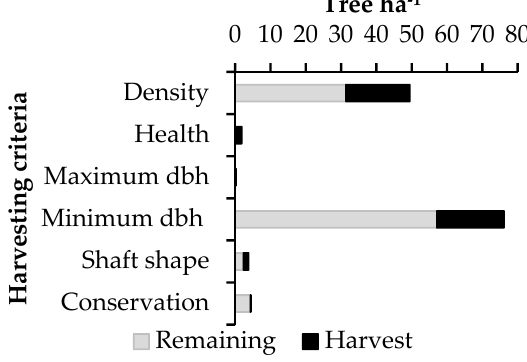
Figure 2. Trees selected for harvest and remaining trees (RM), forest management area (535.6 ha) at Shet Farm, in Dom Eliseu, Par á ,